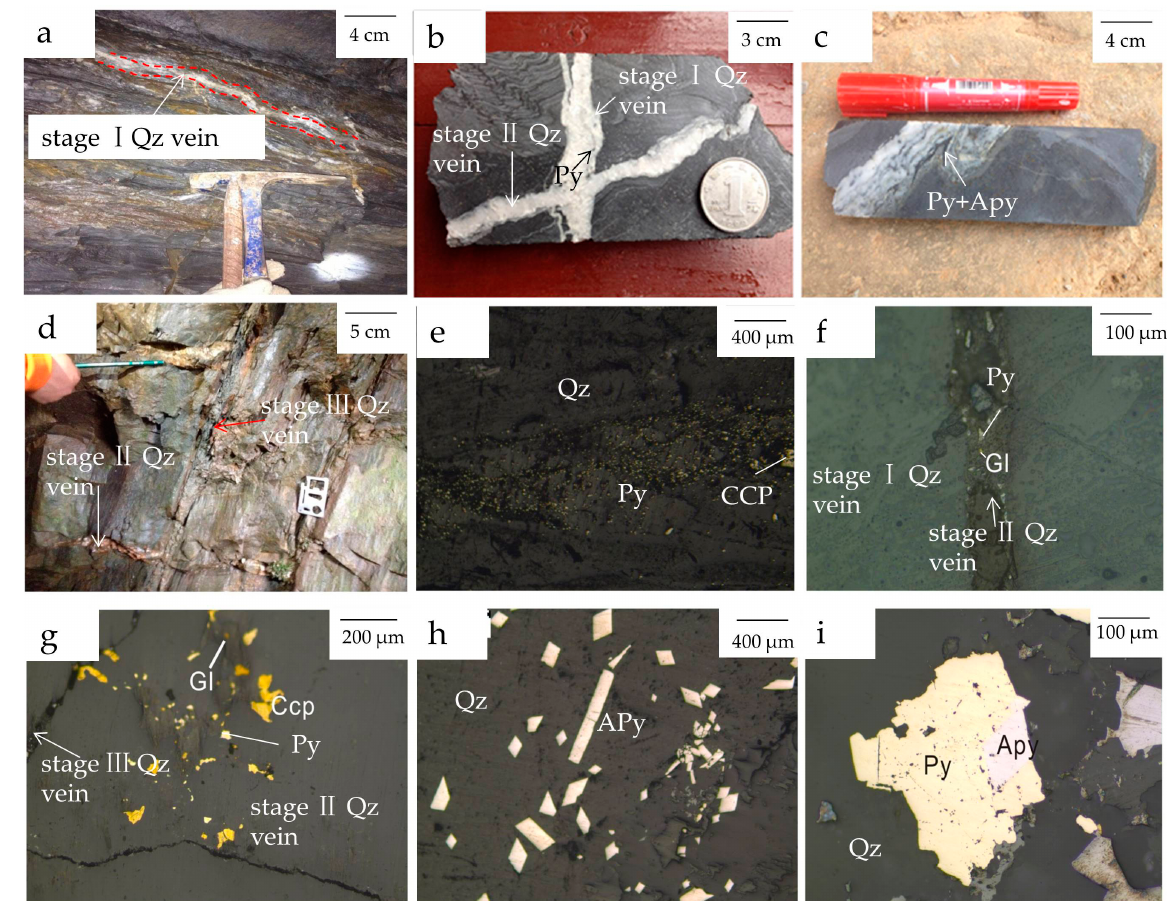
Figure 3. Ore features and photomicrographs of Xiaojiashan gold deposit. ( a ) Stage I smoky-gray quartz veins and alteration halo. ( b ) Stage II quartz vein cut stage I quartz vein. ( c ) Stage II sinuous smoky-gray quartz vein and alteration halo with disseminated pyrite and arsenopyrite. ( d ) Stage III quartz vein cut stage II quartz vein. ( e ) Silicic alterations with disseminated pyrite and arsenopyrite related to gold mineralization. ( f ) Stage II quartz vein overprinted stage I quartz vein. ( g ) Stage III quartz vein overprinted stage II quartz vein. ( h ) Silicic alterations with disseminated arsenopyrite related to gold mineralization in stage II. ( i ) Pyritizat alterations with disseminated arsenopyrite related to gold mineralization in stage II. Abbreviations: Apy, Arsenopyrite; Ccp, Chalcopyrite; Gl, Gold; Py, Pyrite; Qz, Quartz; Sp, Sphalerite.